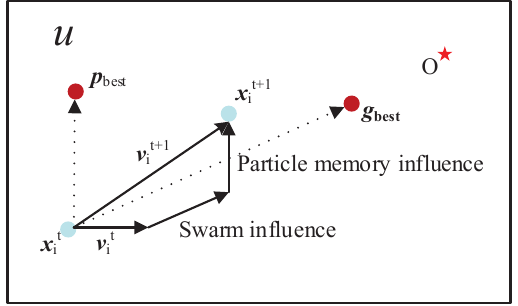
Figure 1. Optimization procedure of